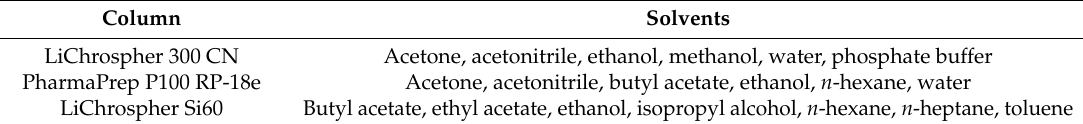
Table 2. Solvents used for the high performance liquid chromatography (HPLC) Screening. Column